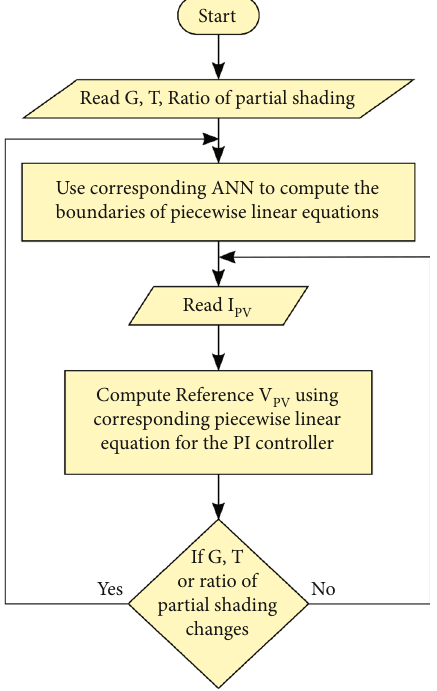
Figure 5: Flowchart of the proposed PVE.